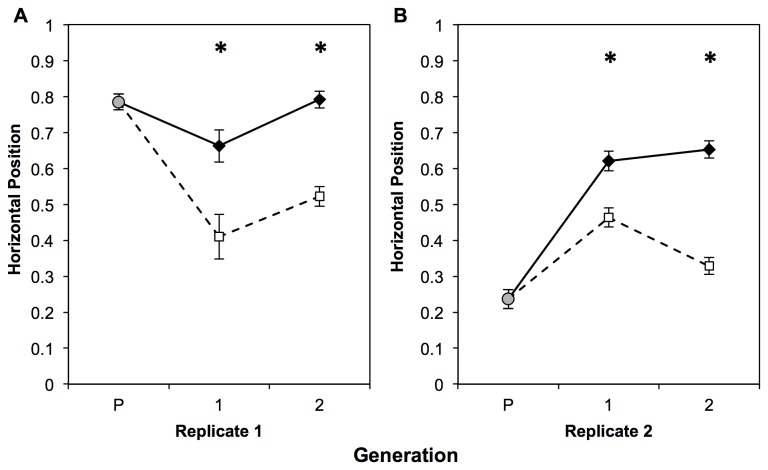
Response to two generations of selection on horizontal position (time near observer) in zebrafish.A: Replicate 1, B: Replicate 2. x-axis generations: P = unselected parental generation (gray circle), 1 = first generation progeny from selected parents, 2 = second generation progeny from selected first generation parents. Black diamonds with a solid line represent means ± SE of High line fish, open squares with a dashed line represent means ± SE of Low line fish. “*” indicate significant (p<0.05) differences between lines within a generation using a mixed-model ANOVA.